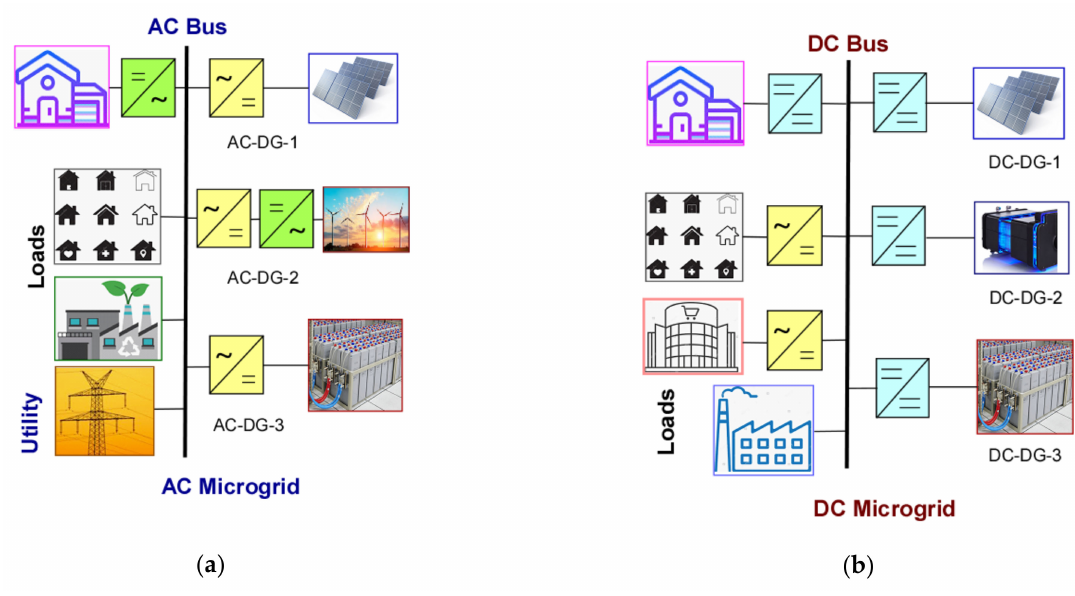
Figure 1. Layouts of alternating current (AC) microgrid (MG) ( a ) and direct current (DC) MG ( b